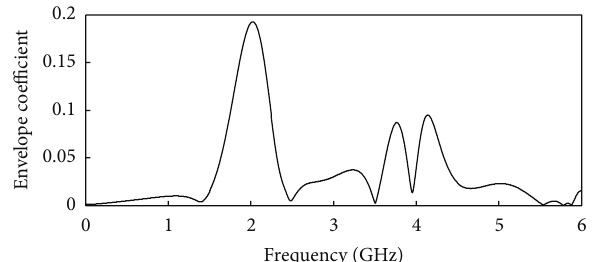
Figure 11: Measured envelope correlation of the proposed multi- band